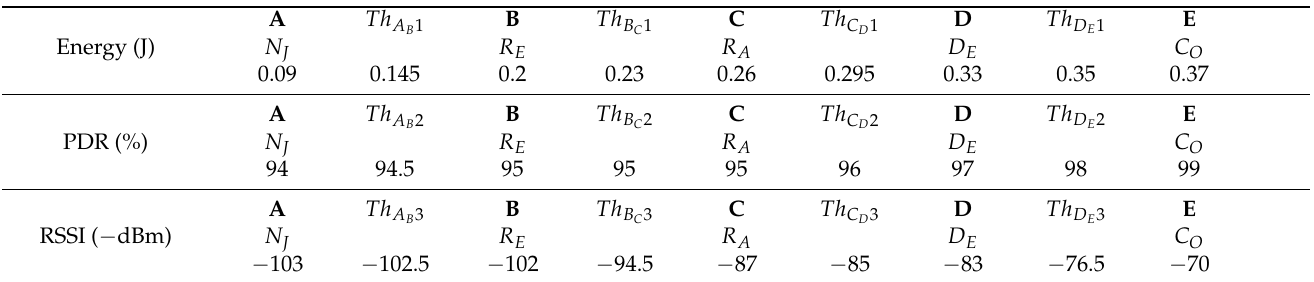
Table 10. Decision threshold